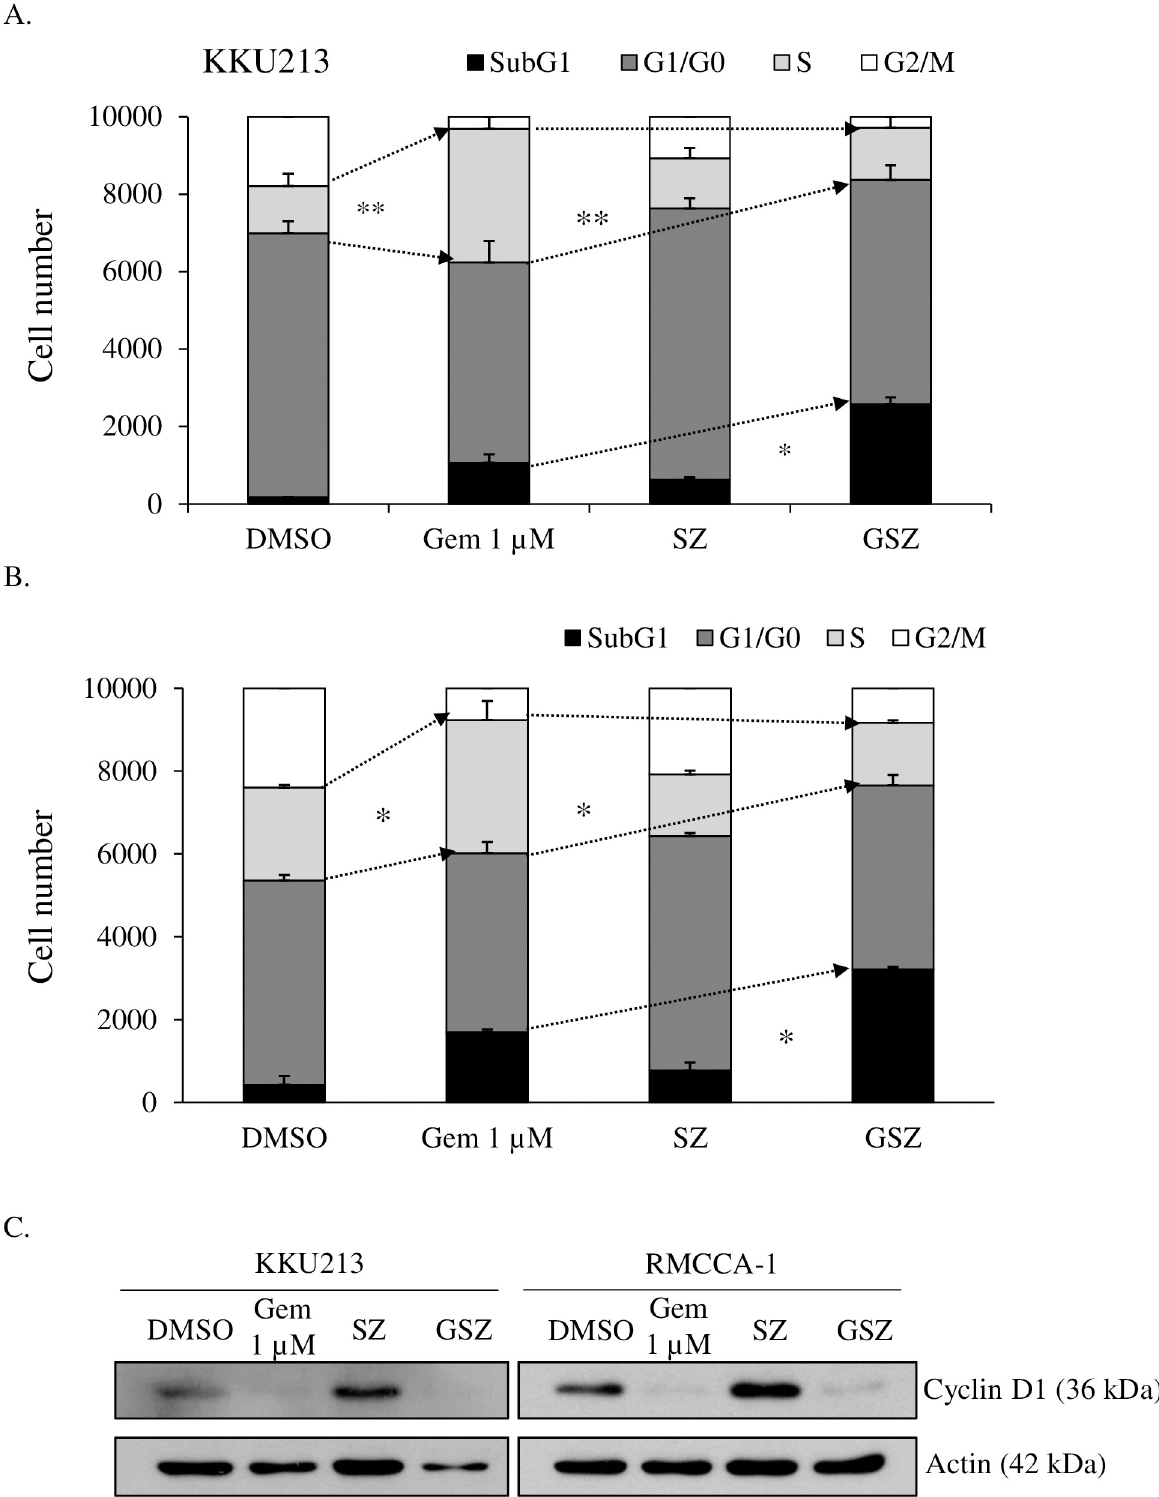
Fig 6. Smac mimetic reverses gemcitabine-induced cell cycle arrest upon caspase inhibition. (A) KKU213 and (B) RMCCA-1 were treated with DMSO, 1 μ M gemcitabine (Gem 1 μ M), 5 nM Smac mimetic and 20 μ M zVAD-fmk (SZ), or GSZ for 48 h. Cells were stained with propidium iodide and cell cycle (sub-G1, G0/G1, S, and G2/M) was analyzed by flow cytometry. Number of cells in each phase, data presented as mean ± S.D.